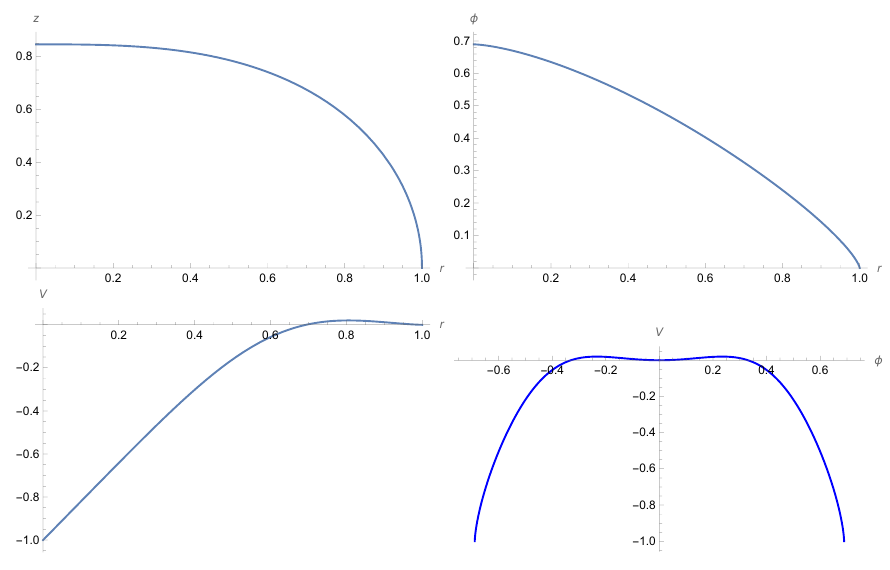
√ 2 . At this time, the φ -